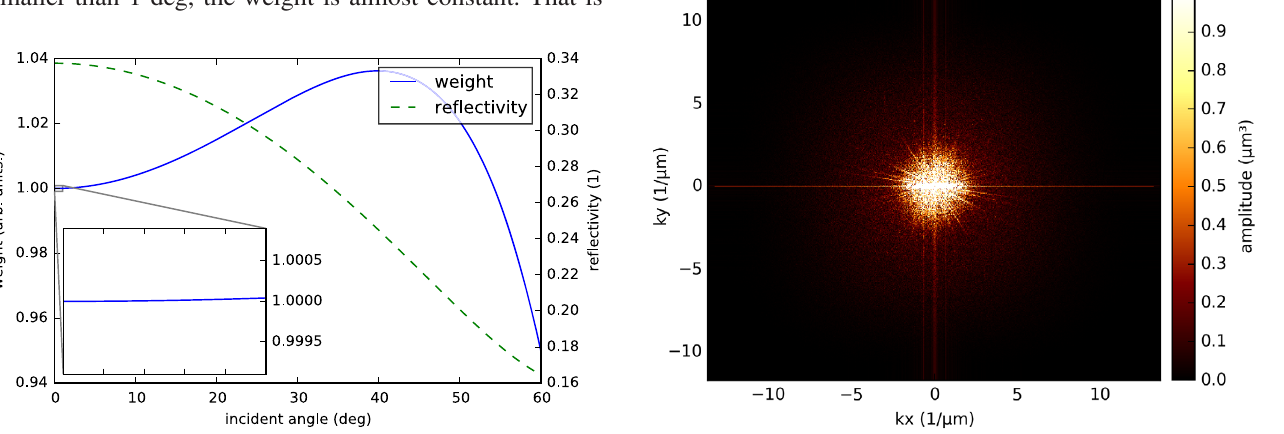
FIG. 9. Weight W ð θ Þ and reflectivity R ð θ Þ vs incident angle θ for a smooth copper photocathode. W ð θ Þ is actually the effective QE, which is proportional to the electron emission intensity on the cathode. The inset is a zoom-in of the weight curve between 0 deg and 1 deg.